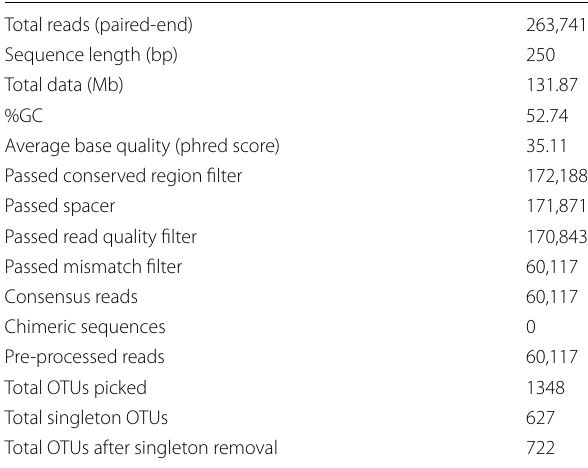
Table 2 Raw read summary of sa-um using Illumina sequencing